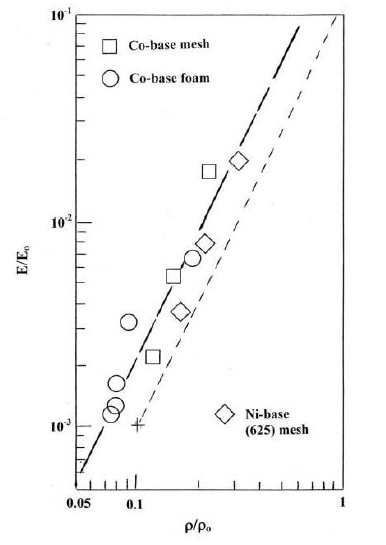
Figure 4. Relative stiffness (E/E Co-Cr-Mo and Ni-base alloy 625 (from Table 1). The dashed line, parallel to the fitted data line, corresponds to a slope of